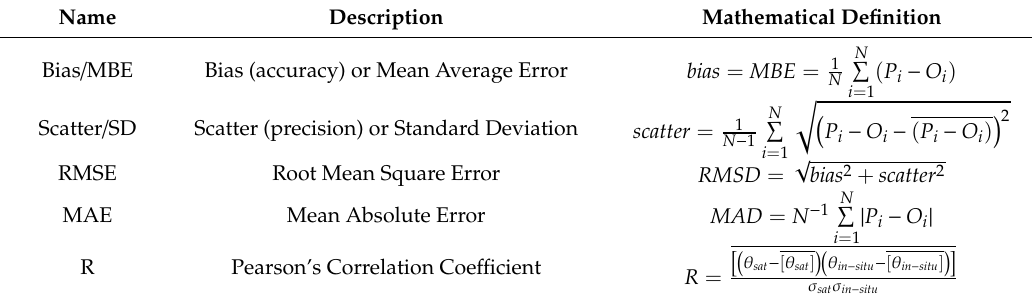
Table 2. Statistical metrics adopted in our study to evaluate the correspondence of predictions with the ground measurements of the parameters compared herein. Subscripts i = 1, ... N are the individual observations (i.e., days included in our analysis), P the predictions, and O the observations. The horizontal bar denotes the mean